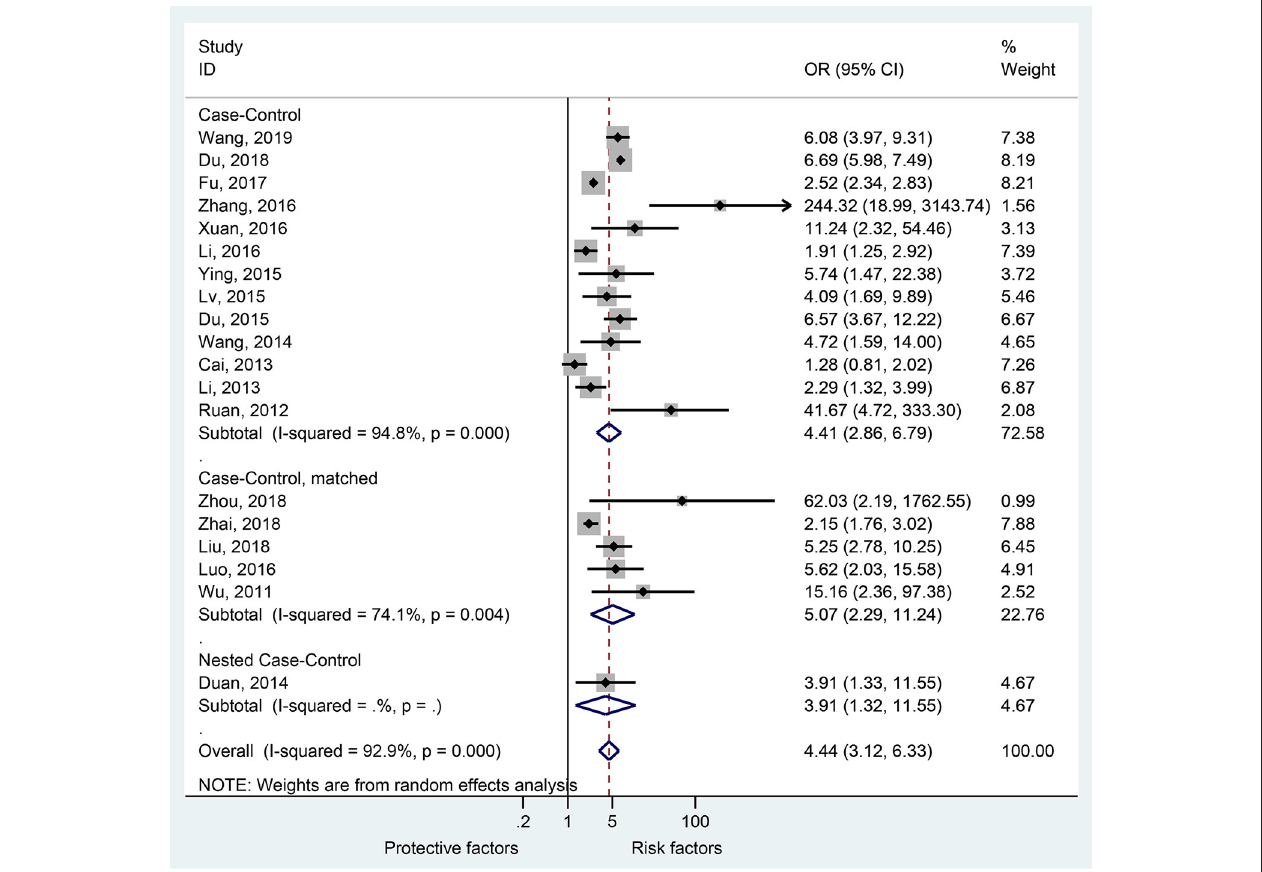
FIGURE 2 | Forest plot for the association of enterovirus 71 with severe hand foot mouth